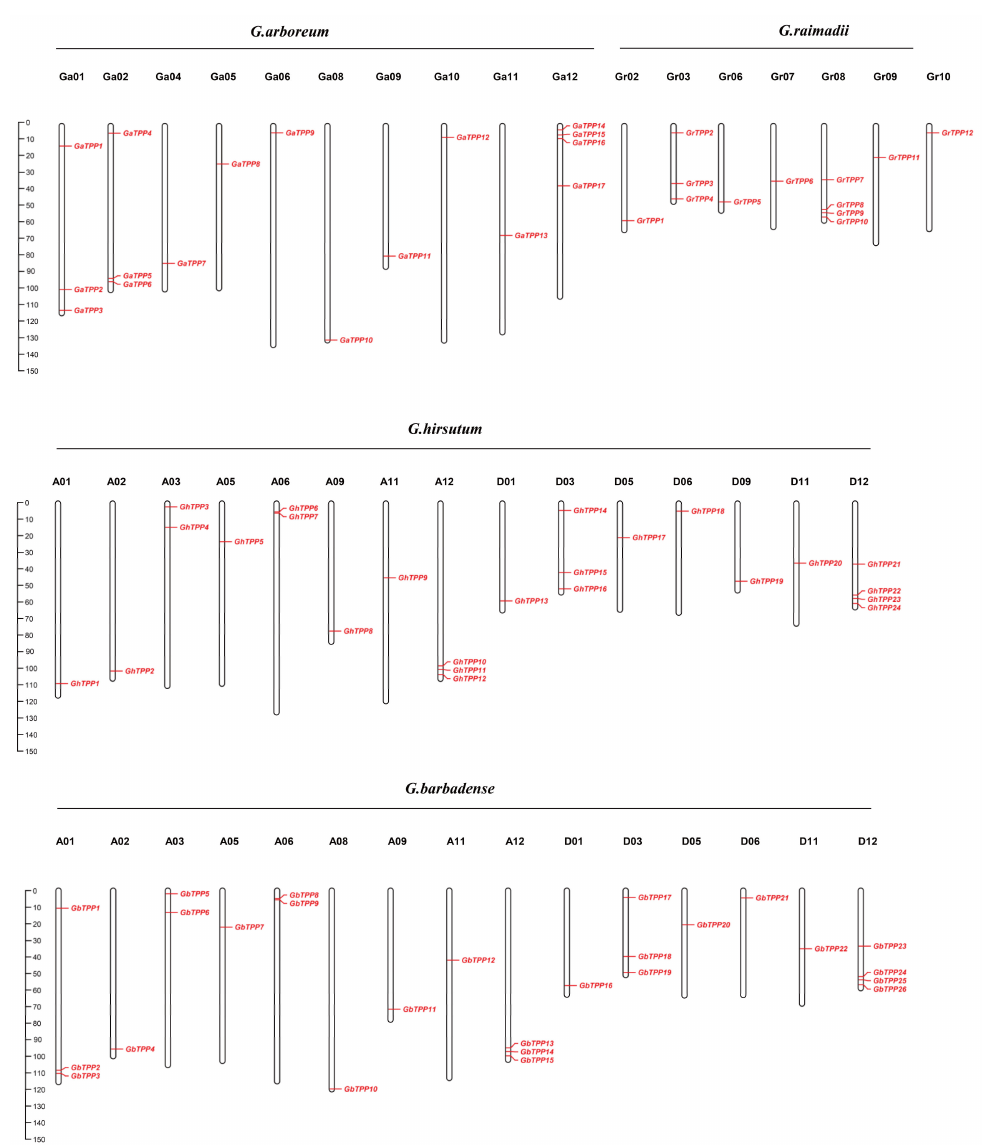
Figure 3. Chromosomal distribution of TPP genes. The red gene ID locations correspond to the positions on the chromosomes; the scale of the chromosomes represents millions of base pairs